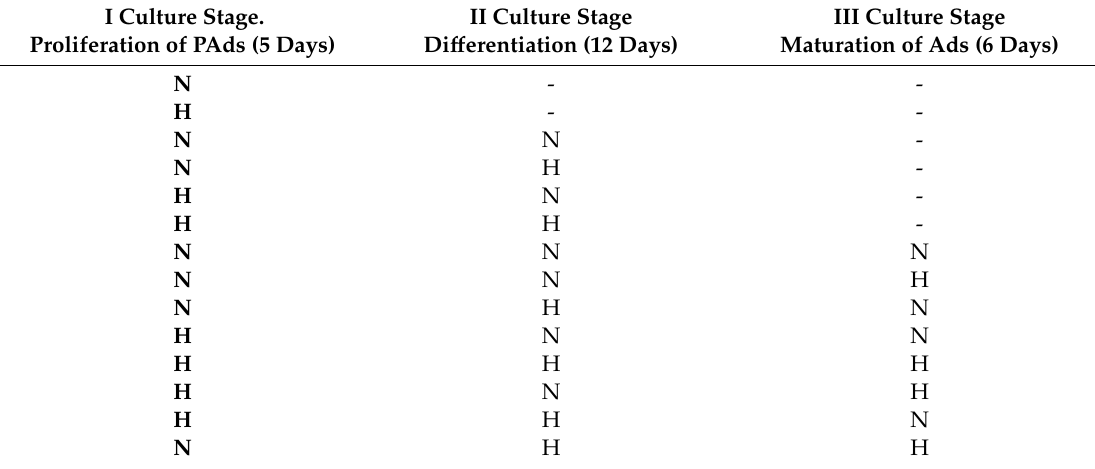
Table 1. Cell culture variants of